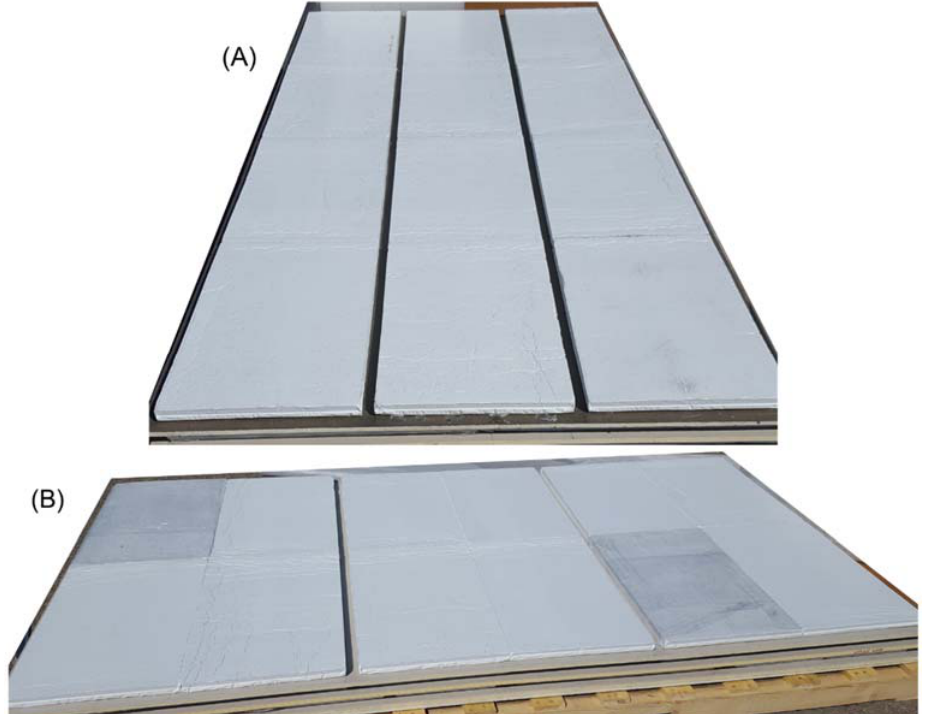
Figure 2. VIP ‐ HD board composites for 2.44 m × 1.22 m samples. Samples ‘A’ and ‘B’ contain VIPs of two different dimensions and in two different configurations. ( A ) VIP butt ‐ jointed along the length in three rows with foam gaps between the rows; ( B ) three groups of four butt ‐ jointed VIPs with foam gaps between the groups.